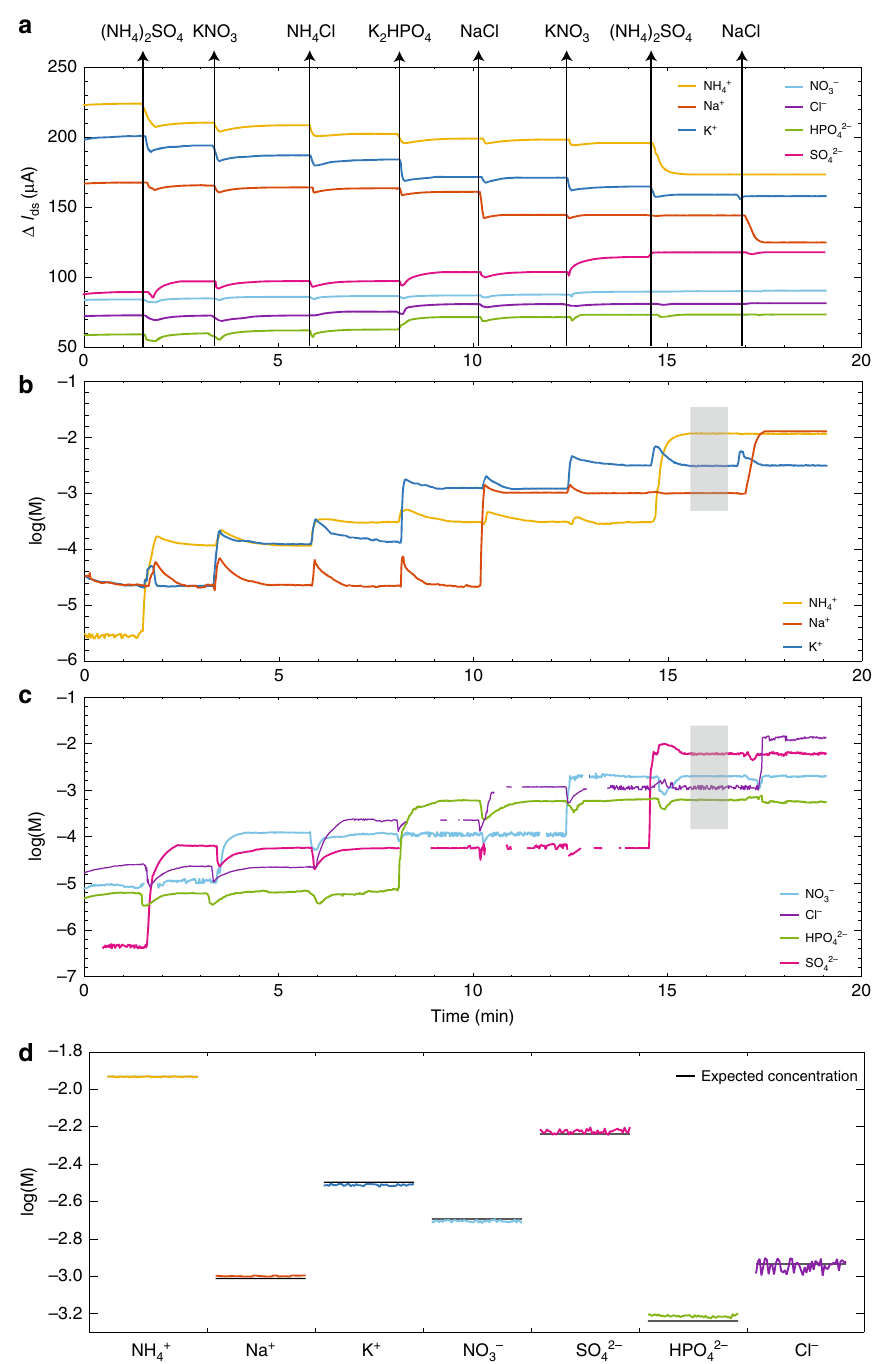
Fig. 6 Real time and simultaneous measurements of ion concentrations in a multi-ion electrolytic solution. a The change in current Δ I ds = Δ I i versus time t for all seven ISFETs measured concurrently in a multi-ion electrolytic solution, spiked at different time intervals with salt mixtures as illustrated by the arrows. b , c The calculated concentrations a i of the cations and anions, respectively, from the measured currents as determined from the Nikolskii – Eisenman equations. d The accuracy of concentration estimation by the ISFET sensor array is analyzed by comparing the concentrations calculated from the ISFET array currents in the shaded time interval with the concentration determined from the volume and mass of the added